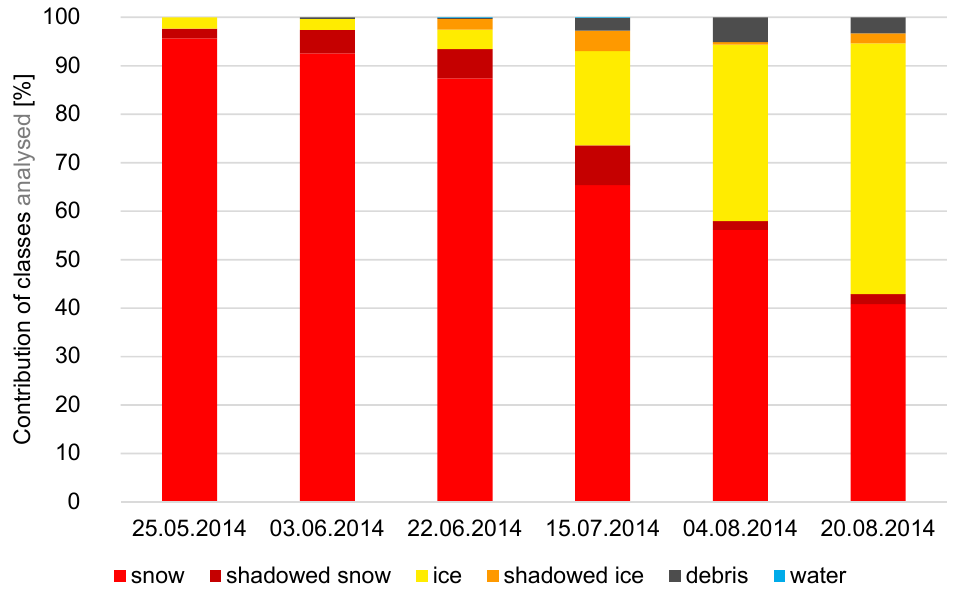
Figure 5. Maximum Likelihood supervised classification statistics. Percentage contribution of the classes analysed at the individual stages in the melting period of 2014.